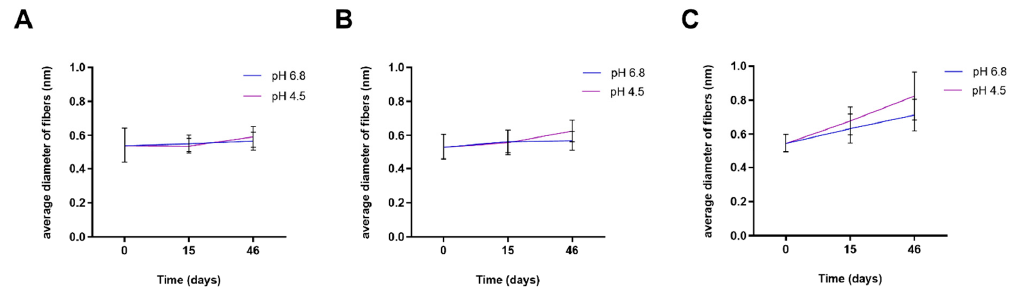
Figure 5. Average diameters of fibers prepared from PLA solutions containing various amounts of RSV after incubation in SAGF-suc (pH 4.5 and pH 6.8) for 15 and 46 days: ( A ) PLA, ( B ) PLA-RSV1, and ( C ) PLA-RSV2.